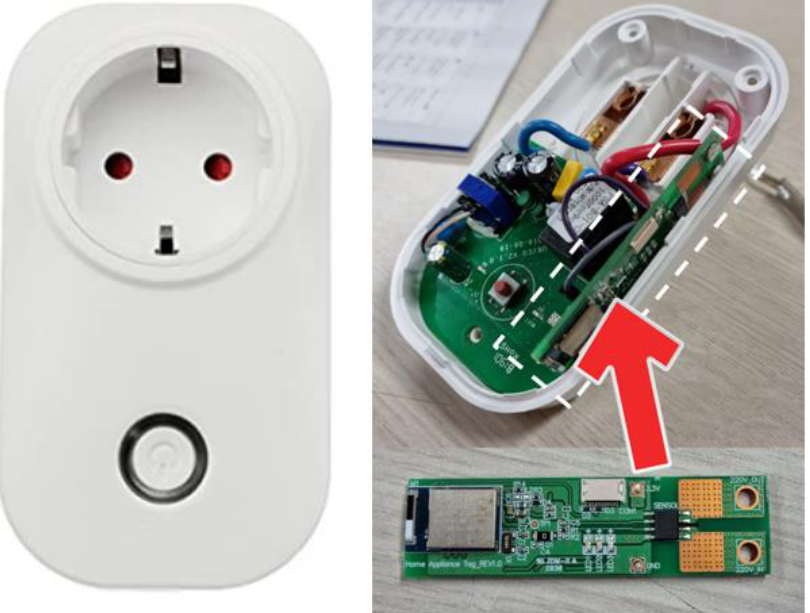
Figure 2. Commercial AC socket and current sensing tag.